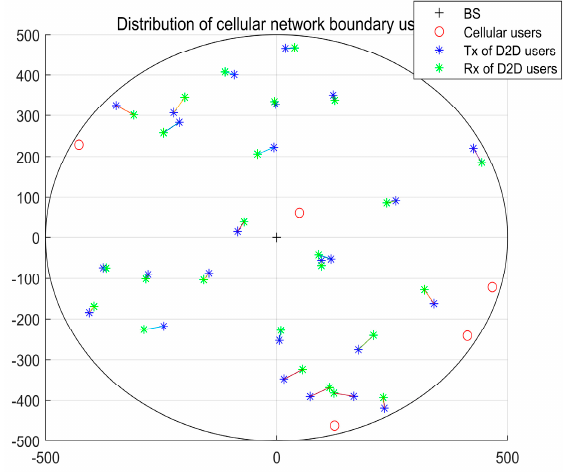
Figure 4. Distribution of cellular network boundary users.